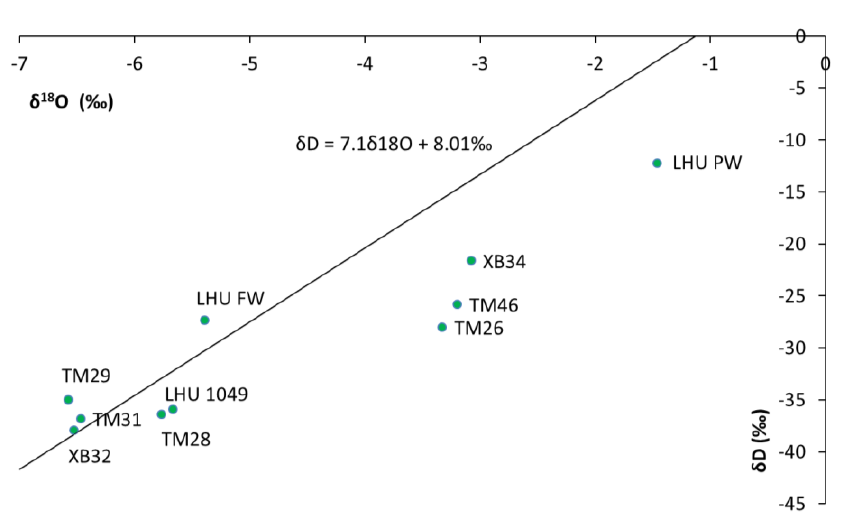
Figure 7. Stable isotope plot for the water samples.